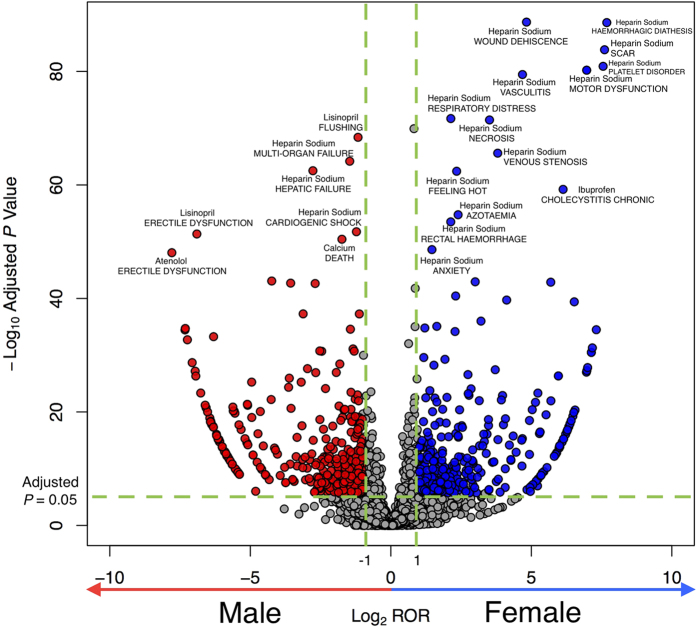
Volcano Plot of Significant Adverse Drug Event (ADE) Signals.In the volcano plot of ADE signals, the signal detection result shows the magnitude (log2 reporting odds ratio [ROR], x-axis) and significance (−log10 adjusted P value, y-axis) for sex- drug-event combinations associations of specific drugs. Each spot represents a specific drug- drug-event combination interaction. The dashed horizontal green line signals statistical significance threshold (P ≤ 0.05 after adjustment with Bonferroni correction). Two vertical green lines show the threshold of ROR (log2 ROR > 1 or < −1). The blue spots represent the drug-event combinations more frequently associated with female patients; the red spots, drug-event combinations more frequently associated with male patients.